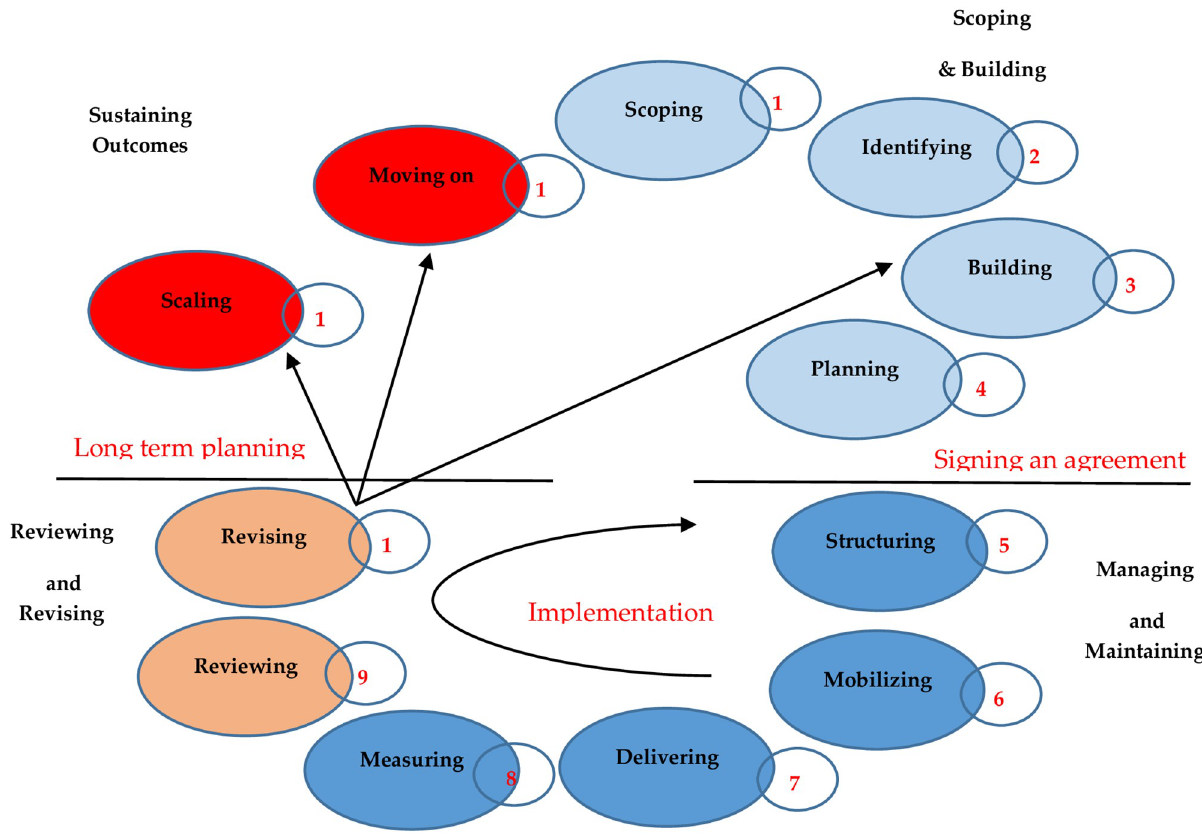
Fig 1. The partnering life cycle framework. Source: Tennyson